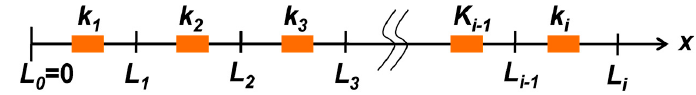
Figure 12. The simple beam model for calculating out-of-plane deformation.